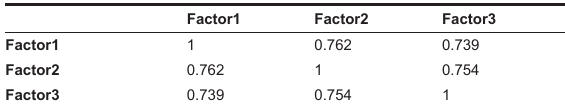
TABLE 5 Intercorrelation matrix of the three sub-sections of the